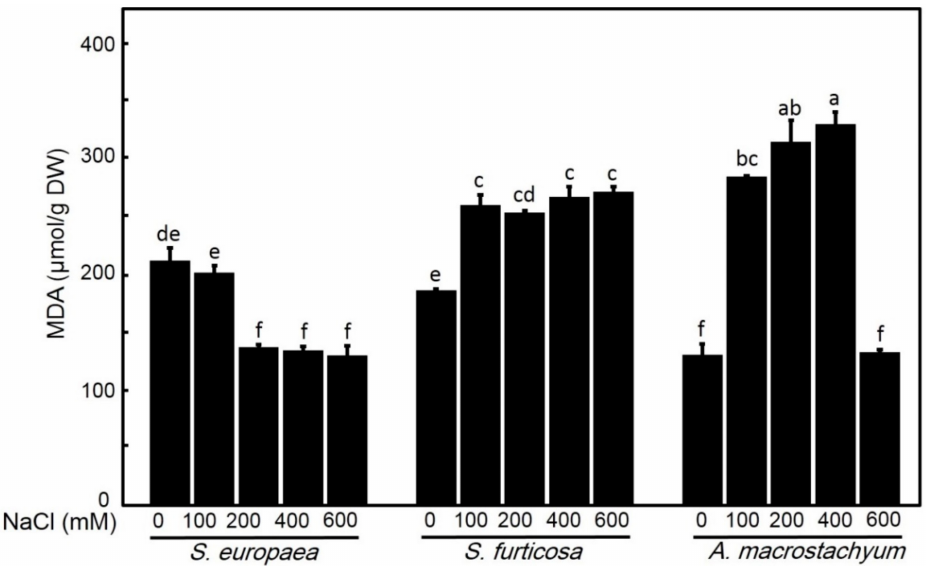
Figure 11. Malondialdehyde contents of S. europaea, S. fruticosa and A. macrostachyum under different NaCl concentrations. Mean ± SE of three replicates. Different letters indicate significant differences ( p < 0.05).